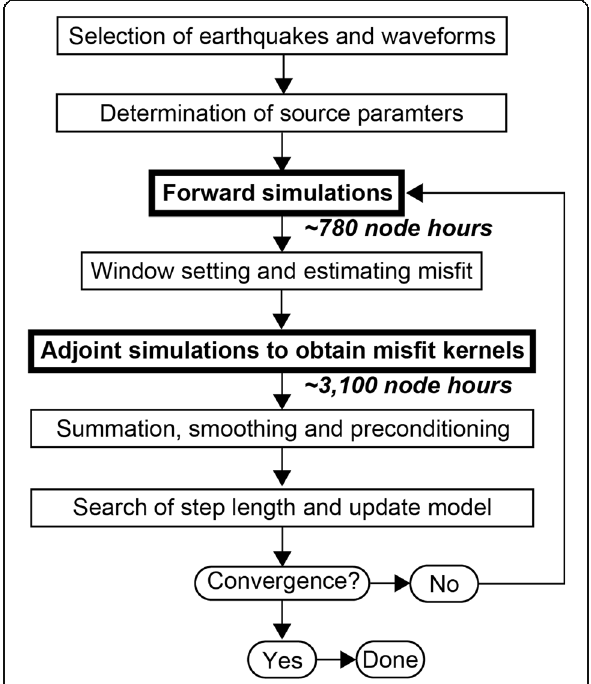
Fig. 5 Research flow of adjoint tomography in the present study. The computational cost estimated for the K computer is also